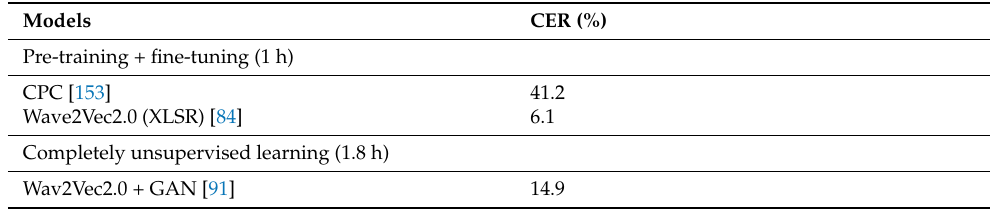
Table 6. SOTA results tested on the Common Voice-Kyrgyz dataset.